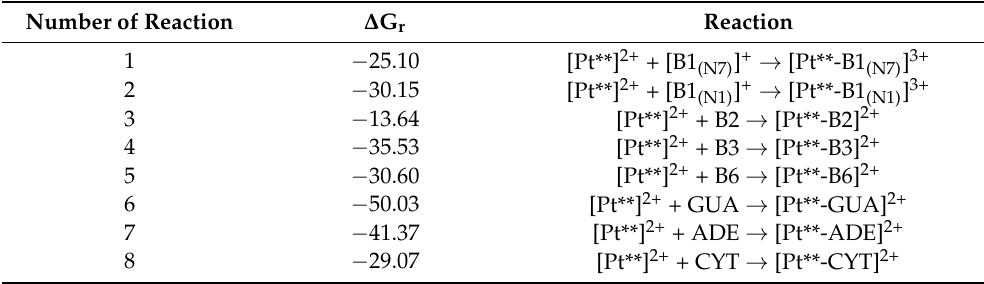
Table 4. The energetic characteristics of the Pt-diaqua reactions with vitamin B and nucleobases obtained at the MN15/def2-TZVP level of theory. All energies are given in kcal/mol. Number of Reaction ∆ G r Reaction 1 −